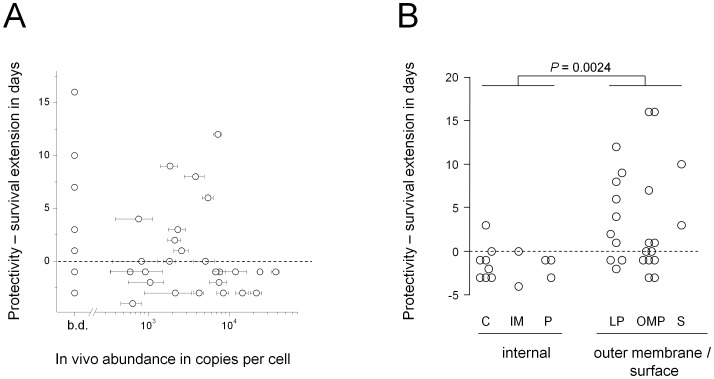

Salmonella antigen protectivity does not correlate with in vivo antigen abundance but depends on antigen localization within the Salmonella cell.
A) Relationship between antigen protectivity and in vivo abundance as determined by quantitative proteome analysis of ex vivo purified Salmonella (means ± SD for three independently infected mice; b.d., below detection threshold). B) Relationship between antigen protectivity and antigen localization within Salmonella (C, cytosol; IM, inner membrane; P, periplasm; LP, outer-membrane associated lipoprotein; OMP, outer membrane protein; S, surface). Statistical significance of differences between internal and outer membrane/surface antigens was tested using the non-parametric Mann-Whitney U test.